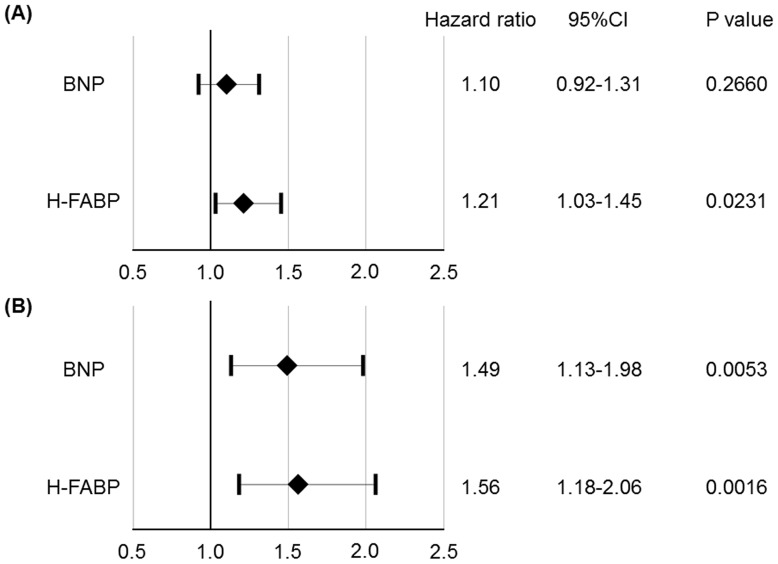
Multivariate Cox proportional hazard regression analysis for predicting all-cause deaths (A) and cardiovascular deaths (B).(A) Hazard ratios after adjustment for age, gender, smoking, previous cardiovascular disease, obesity, hypertension, diabetes mellitus, metabolic syndrome, chronic kidney disease, atrial fibrillation, and BNP. (B) Hazard ratio after adjustment for age, gender, atrial fibrillation and BNP.